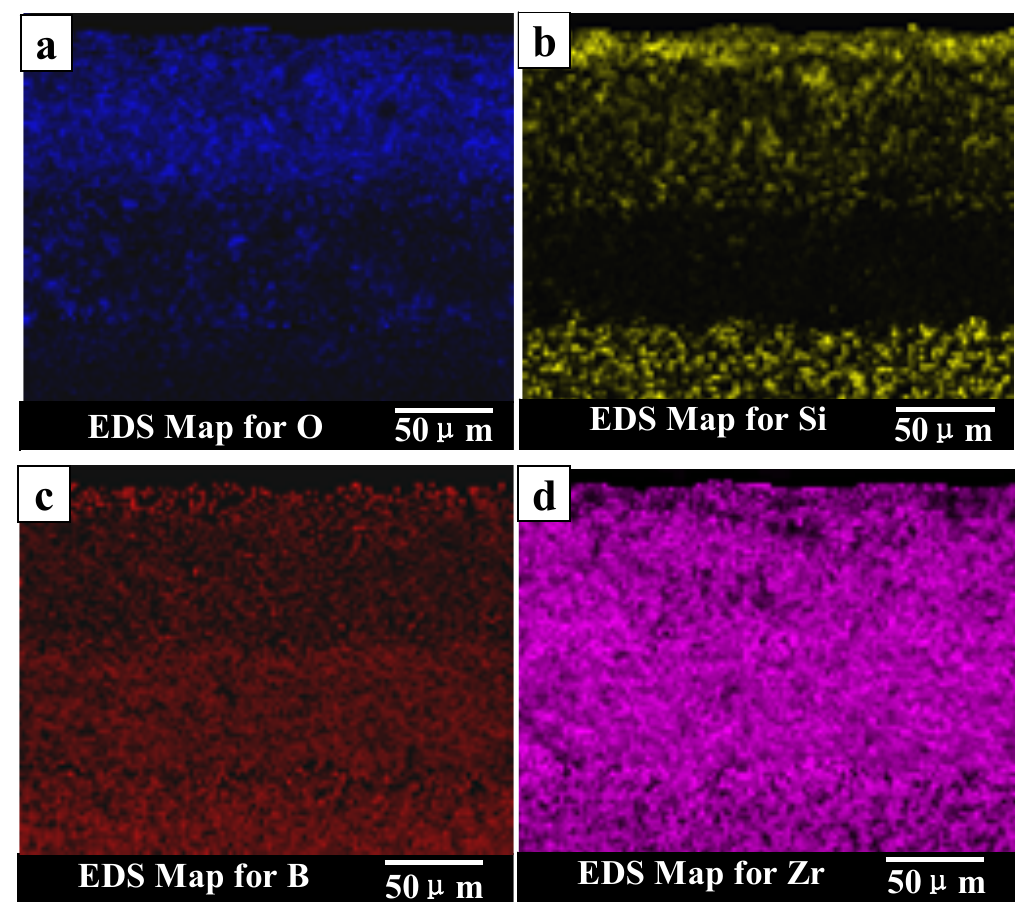
Figure 9. Elemental maps for the oxide scale of ZS30 after ablation under condition 1.